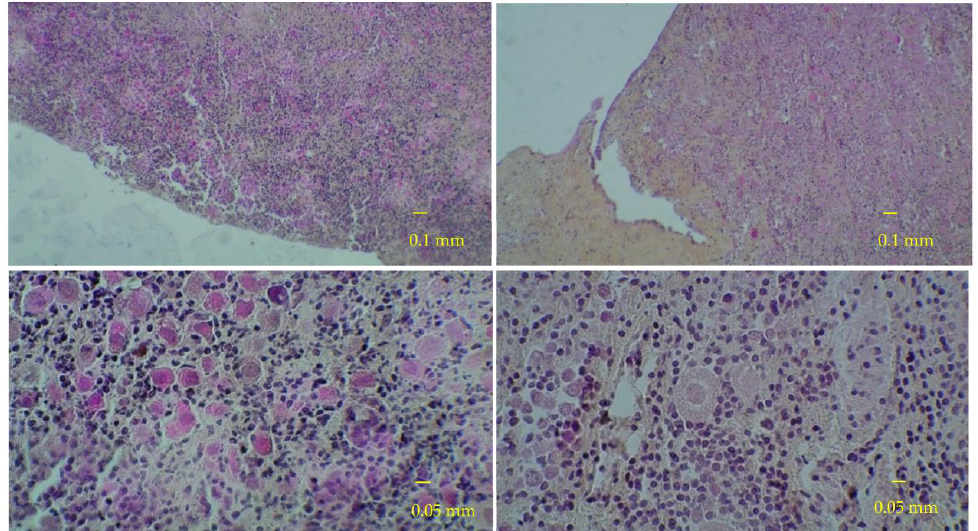
Figure 4. Fetal ovarian tissue in culture at day 90. Slices colored with hematoxylin-eosin-safran at low and high magnification. Left panels: control cultures. Right panels: bioreactor cultures. 3.2. Results of the Second Set of Analyses with All Present Follicles as Denominator In the second set of analyses, using normalization by the number of all present folli- cles, the percentage of growing follicles varied widely between ovaries at D0 (0 to 29.3%).